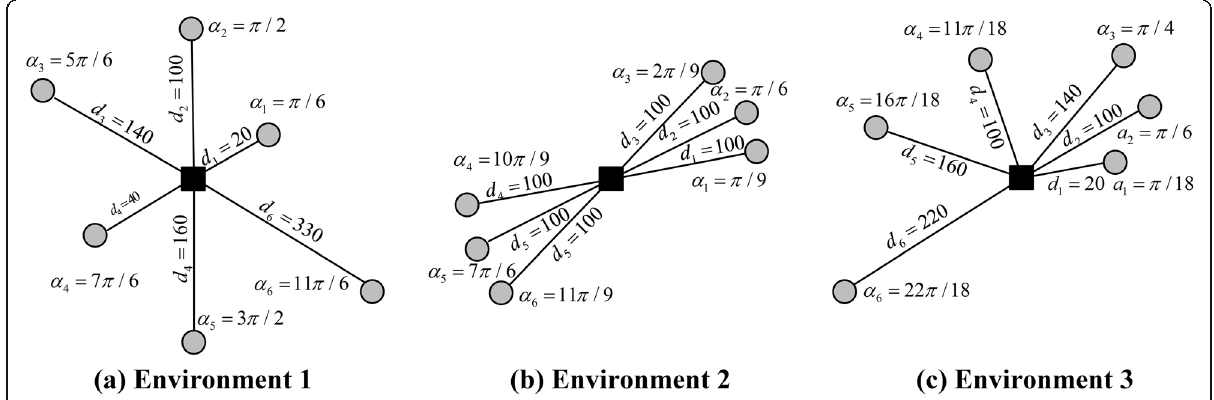
Fig. 3 The layout of the three different simulation environments. a Environment 1. b Environment 2. c Environment